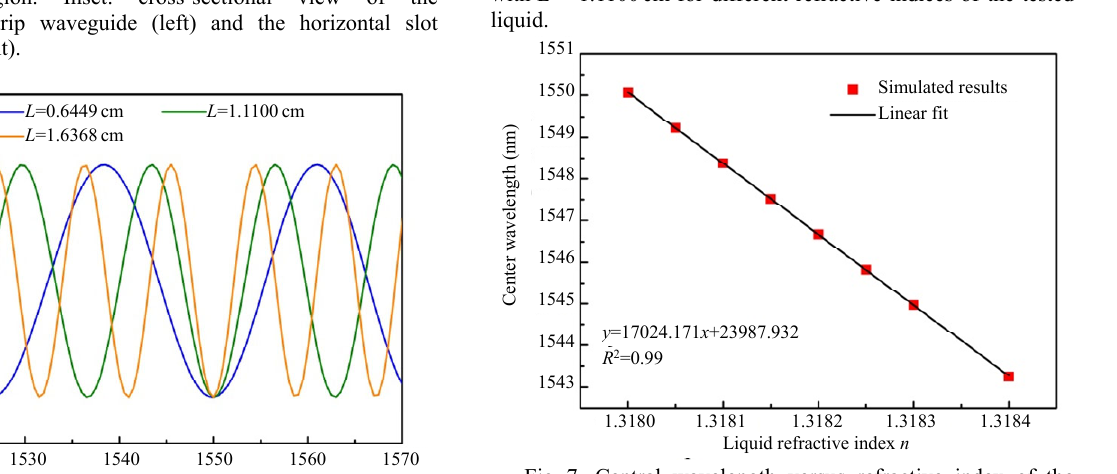
Fig. 7. Central wavelength versus refractive index of the tested liquid, and linear fit are used to calculate the sensitivity of the designed MZI